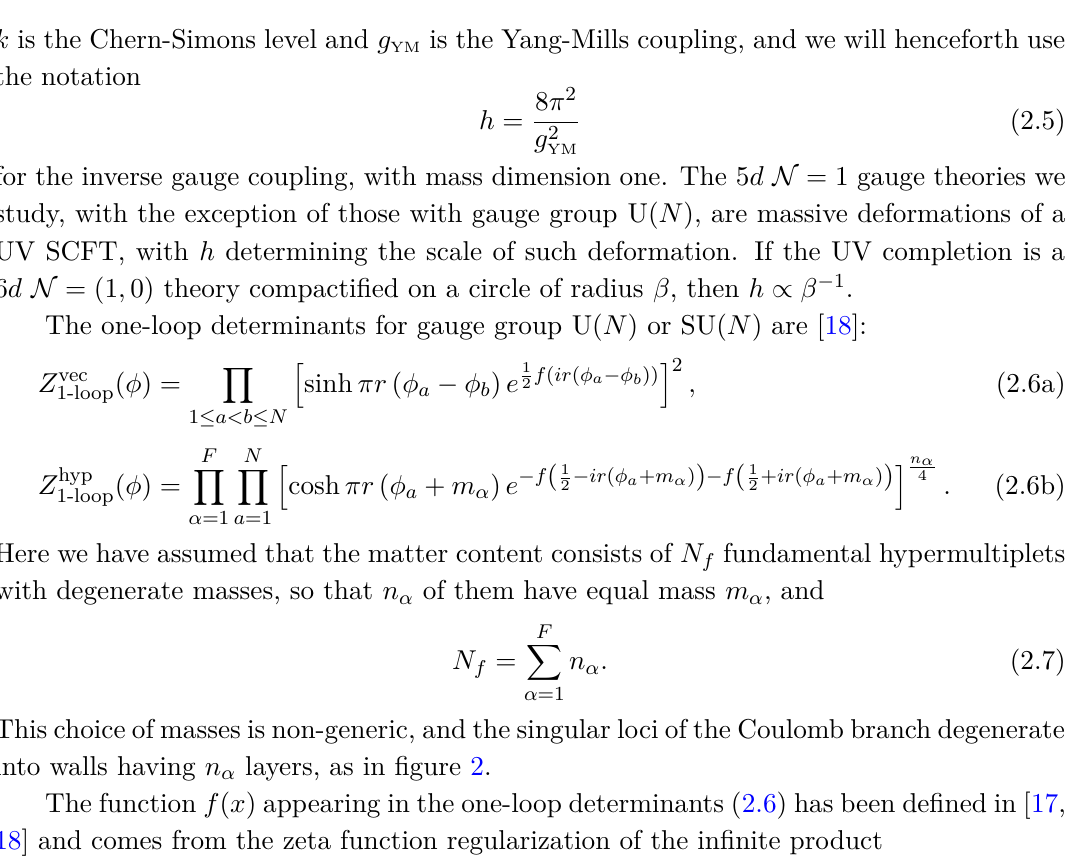
Figure 2 . When the masses are degenerate, n α walls inside the Coulomb branch